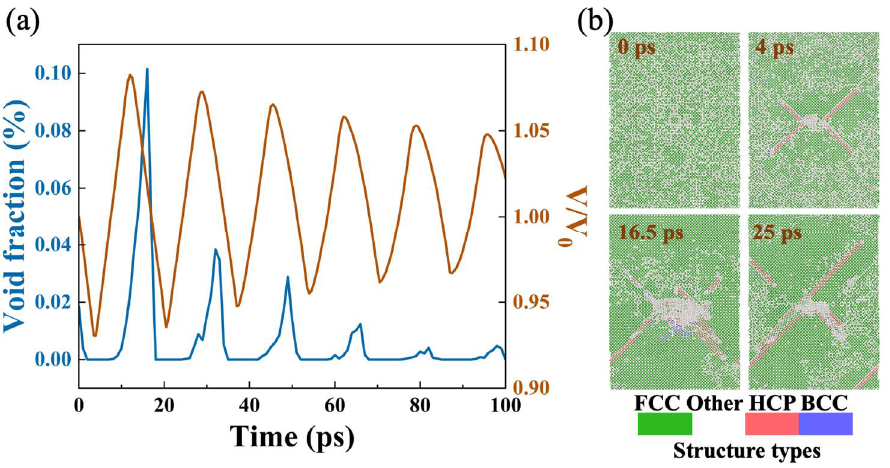
Figure 5. ( a ) Changes in sample volume and void volume fraction. ( b ) Types of structure around the preset void at 0, 4, 16.5, and 25 ps.